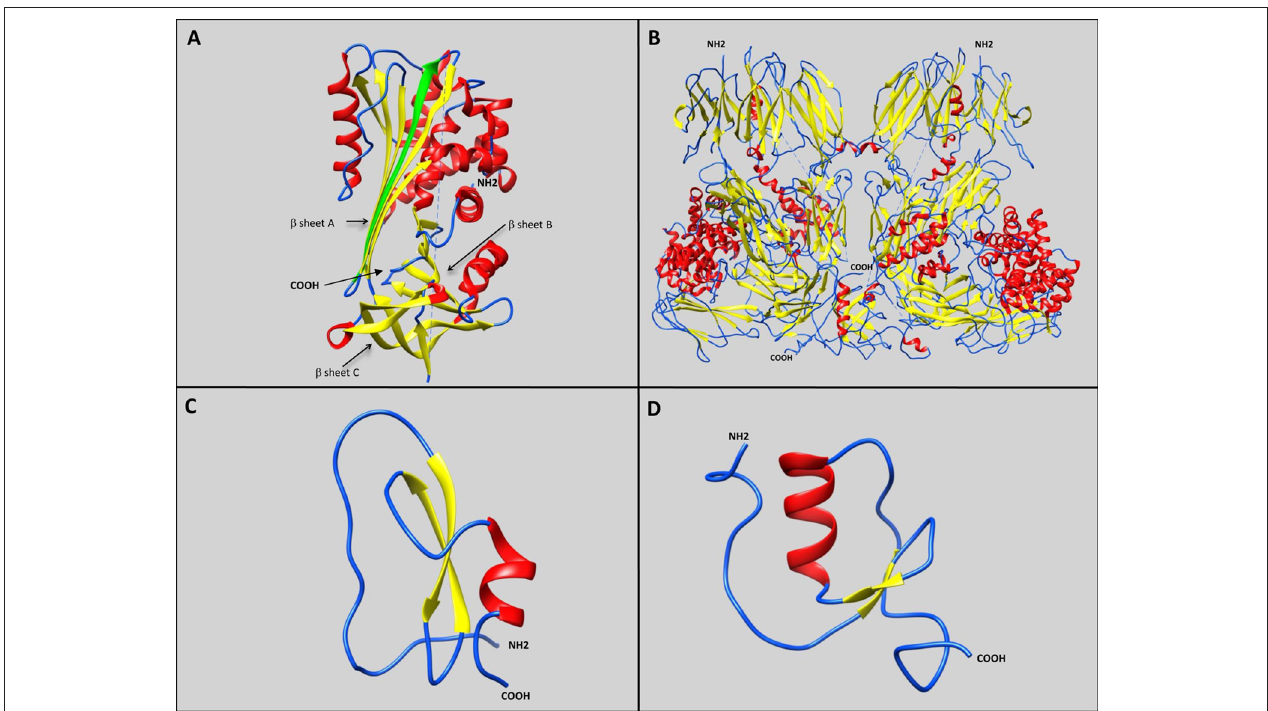
FIGURE 1 | Representative schematic diagrams of secondary structures of the four types of serine protease inhibitors: serpins, α 2 macroglobulins, Kunitz-type inhibitors, and Kazal-type inhibitors. Loops, β -sheets, and α -helices are labeled with blue, yellow, and red, respectively. (A) IRS 2 serpin from the I. ricinus tick showing the three β -sheets A, B, and C ( Chmelar et al., 2011; PDB accession number: 3NDA). The green arrow represents the additional strand (s4A) formed after proteolysis, resulting in Reactive Center Loop cleavage, and insertion of the amino-terminal portion into the A β -sheet. (B) Human α 2 macroglobulin complement component 5 in native homodimer conformation (Fredslund et al., 2008; PDB accession number: 3CU7). (C) Kunitz-type inhibitor Tick-Derived Protease Inhibitor (TDPI) from R. appendiculatus harboring one Kunitz domain composed of β -sheets and an α -helix stabilized by three highly conserved disulphide bridges ( Paesen et al., 2007; PDB accession number: 2UUX). (D) Kazal-type inhibitor Dipetalin from blood-sucking insect Dipetalogaster maximus . harboring one Kazal domain composed of one α -helix with adjacent ß-sheets and loop (Schlott et al., 2002; PDB accession number: